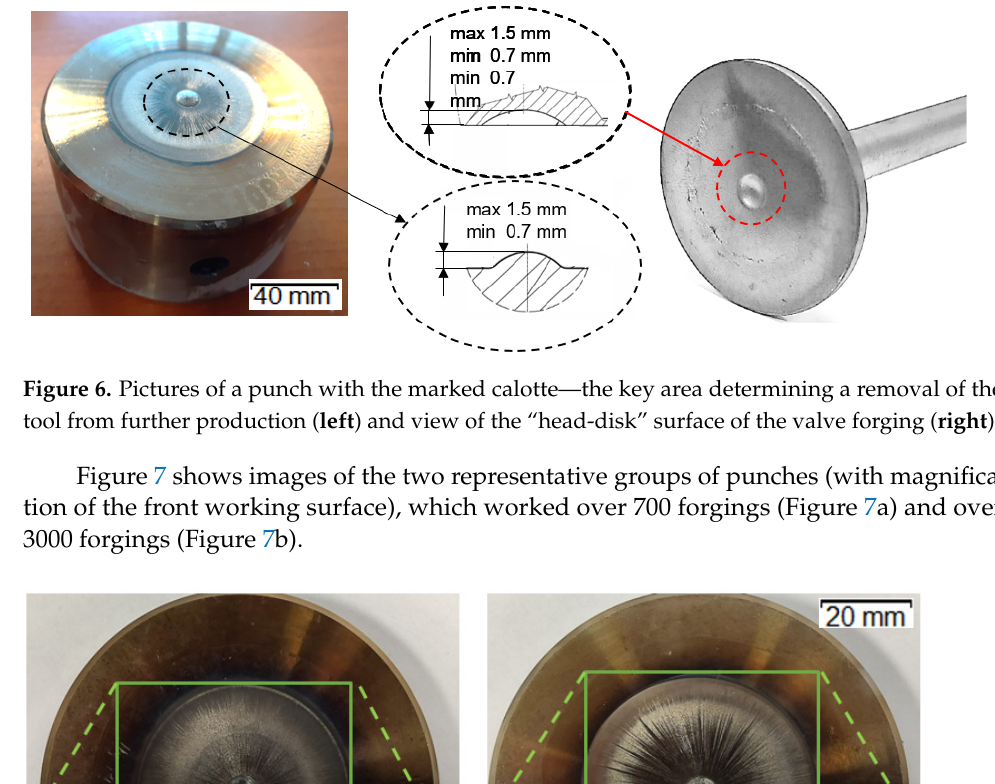
Figure 6. Pictures of a punch with the marked calotte—the key area determining a removal of the tool from further production ( left ) and view of the “head-disk” surface of the valve forging ( right ). Figure 7 shows images of the two representative groups of punches (with magnifica- tion of the front working surface), which worked over 700 forgings (Figure 7a) and over 3000 forgings (Figure 7b).